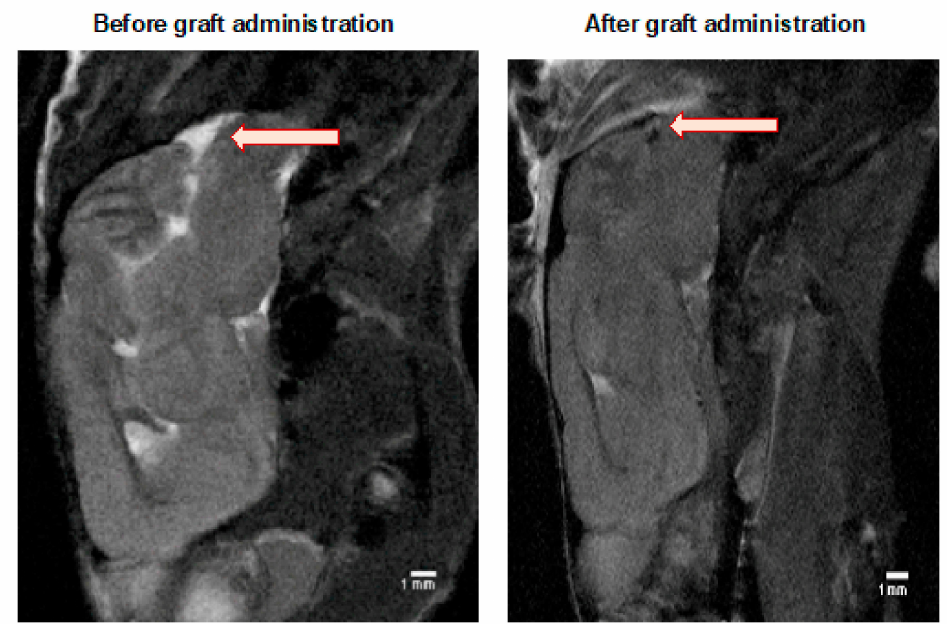
Figure 3. MRI evaluation of the GRPs’ post-transplant localization in CNS: The MRI scan image of the representative (SCID) mouse at the day before (left picture) and a day after (right picture) of murine GRP transplantation into cisterna magna. The black dot (arrow), visible on the right picture shows the localization of SPIO-labelled cells. Abbreviations: GRP-glial-restricted progenitor cell; MRI-magnetic resonance imaging; SPIO-superparamagnetic iron